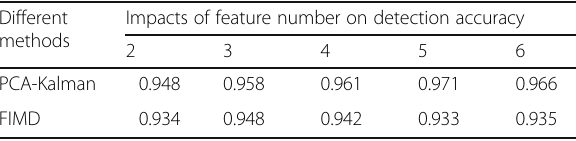
Table 7 The effect of the number of features of different methods on the detection